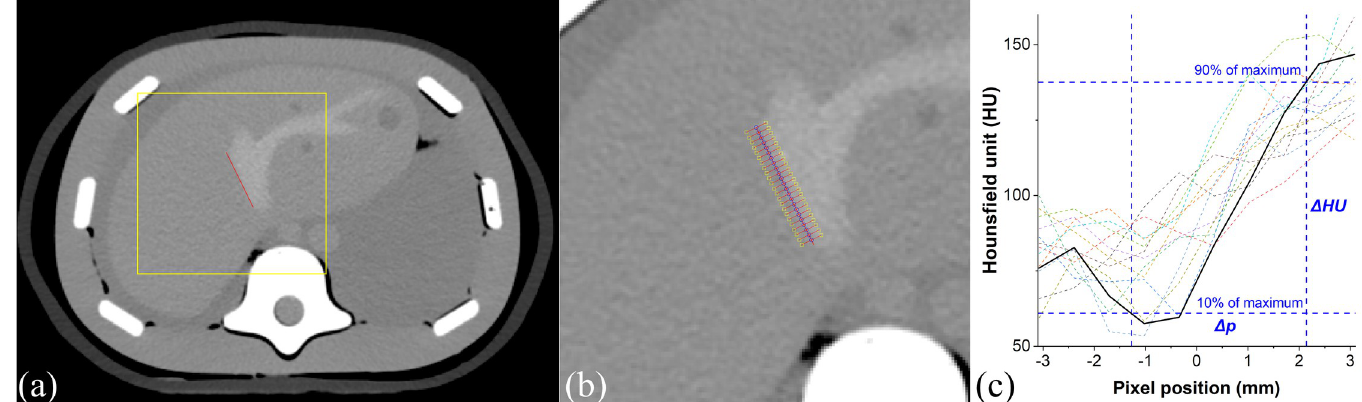
Fig 3. (a) An example showing enhanced vessel on a triple modality 3D abdominal phantom where the red line indicates the manually drawn edge component. (b) Perpendicular line profiles on given manual edge line. (c) Dashed lines show the edge rise trend signifying the vessel sharpness, whereas the bold solid line denotes the average